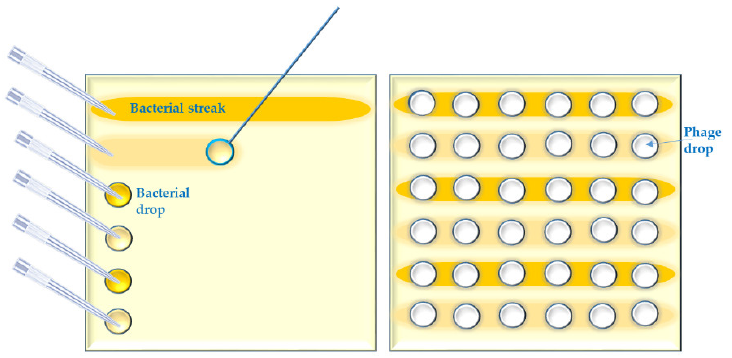
Figure A2. Diagram depicting the “spot on streak” method.